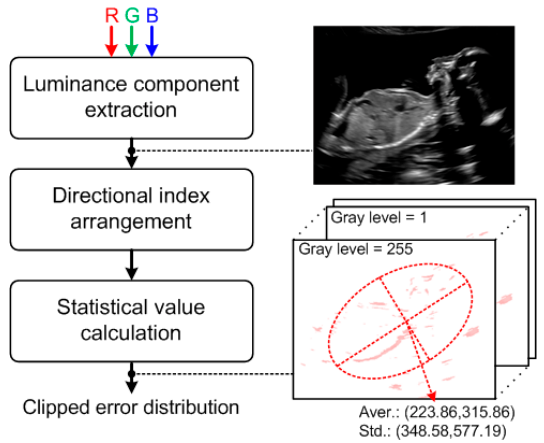
Figure 3. Block diagram for analyzing the clipped error distribution.